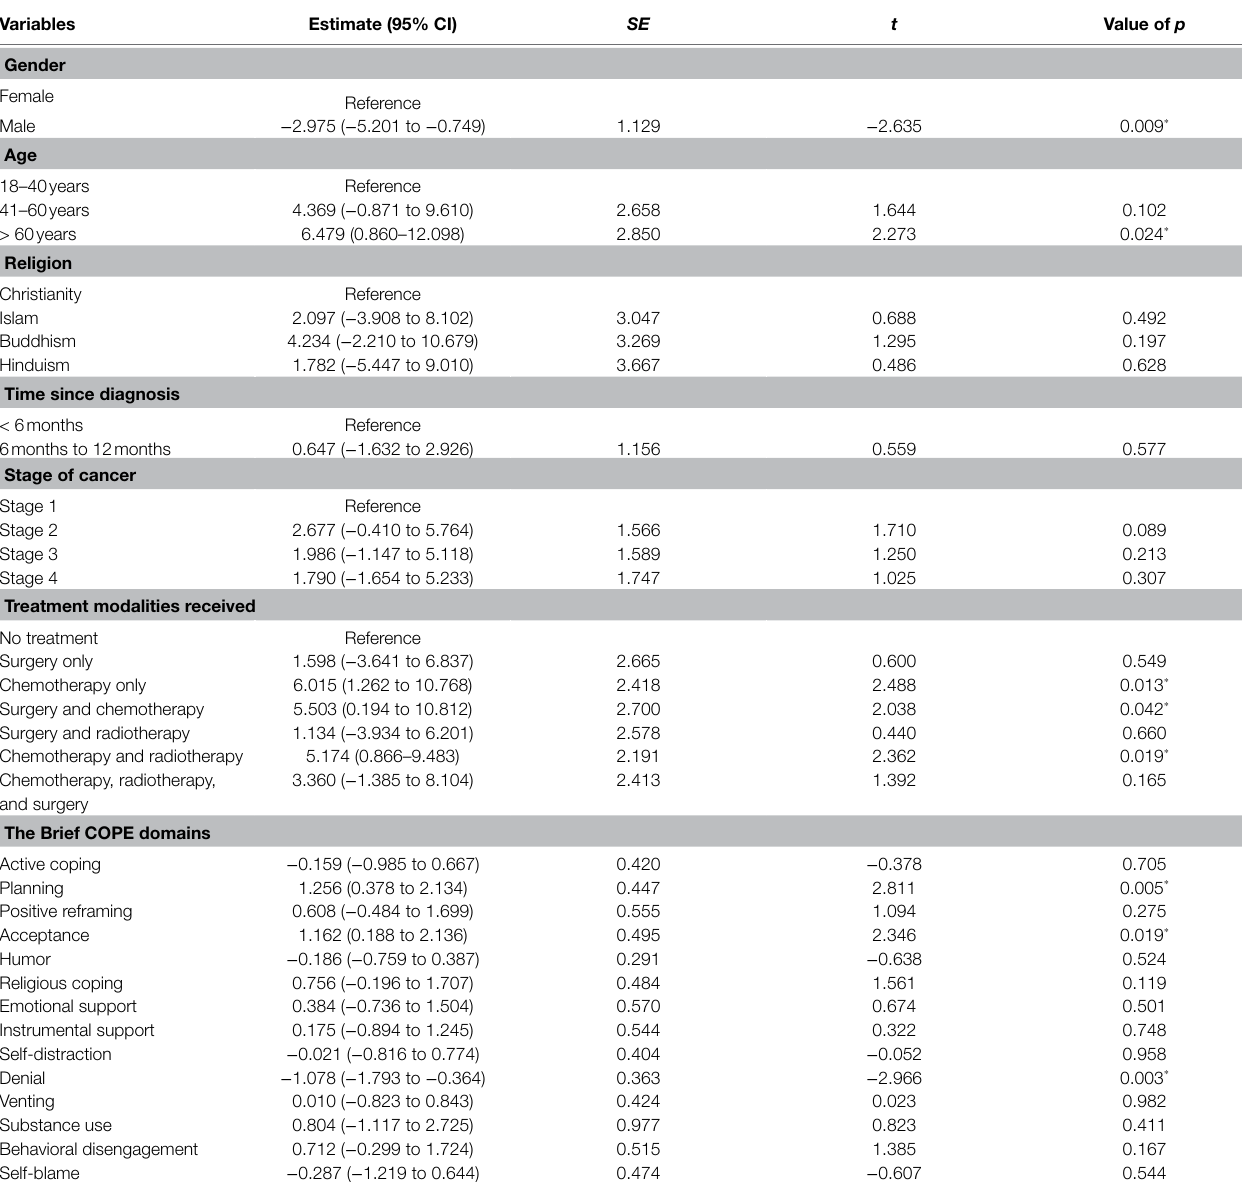
TABLE 3 | The random intercept model between the socio-demographic and clinical characteristics, and the Brief COPE domain scores (independent variables), and total PTGI-SF scores (dependent